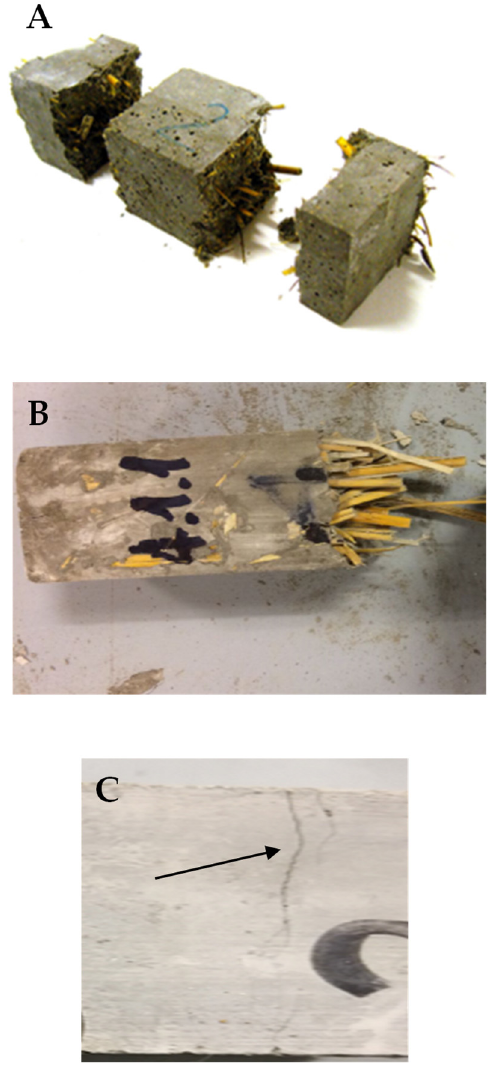
Figure 10. Fibres horizontal arrangement in ( A ) P/S3 and ( B ) S4 specimens. ( C ) Discrete cracks after rupture in the straw specimens (evidenced by the arrow), with the two parts of the sample still connected by the organic aggregate.